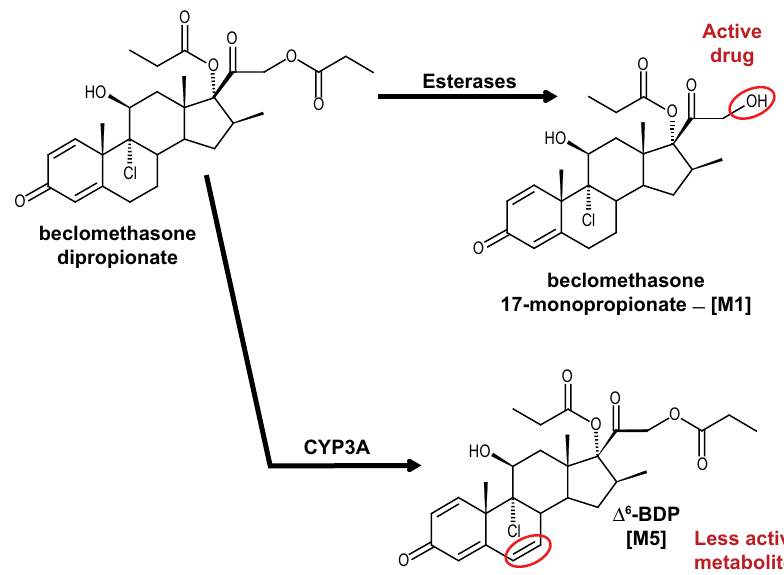
Figure 1. Metabolic scheme for the production of [M1] (the active form of the drug) by esterase enzymes and [M5] by CYP3A enzymes.